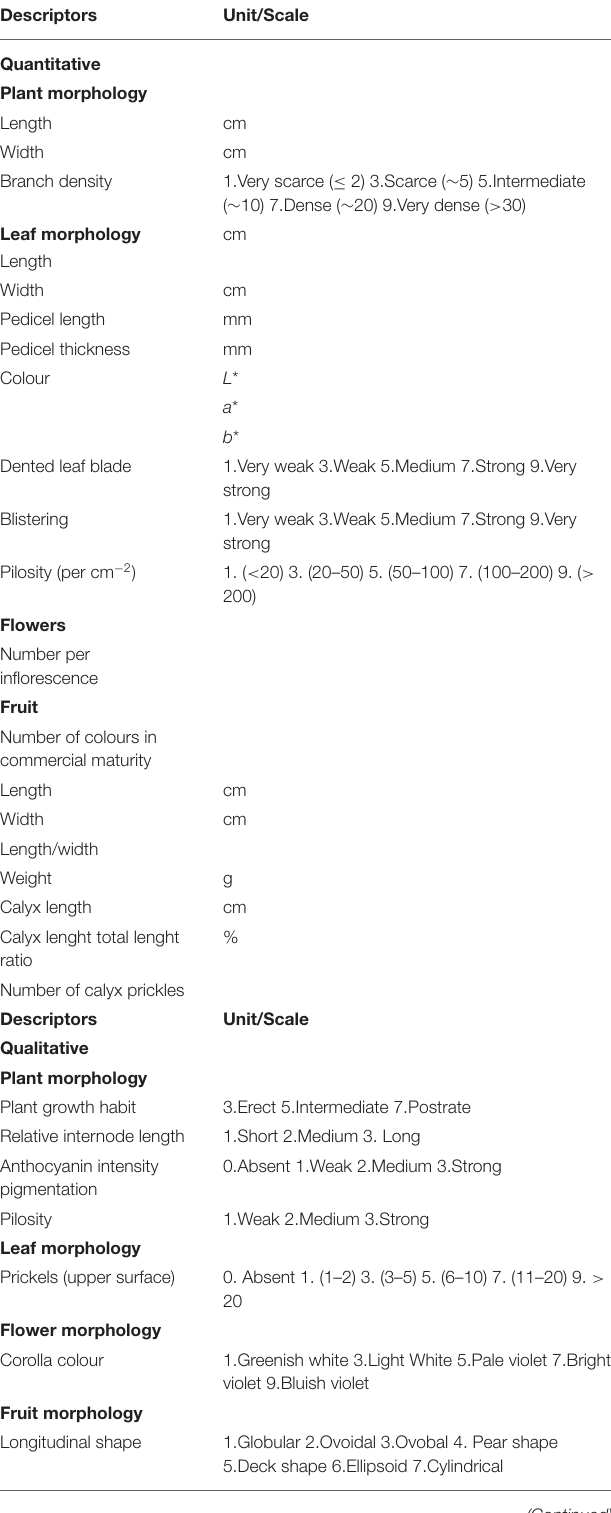
TABLE 2 | List of the descriptors used for phenotyping according to the International Board for Plant Genetic Resources descriptors (IBPGR 1990) for